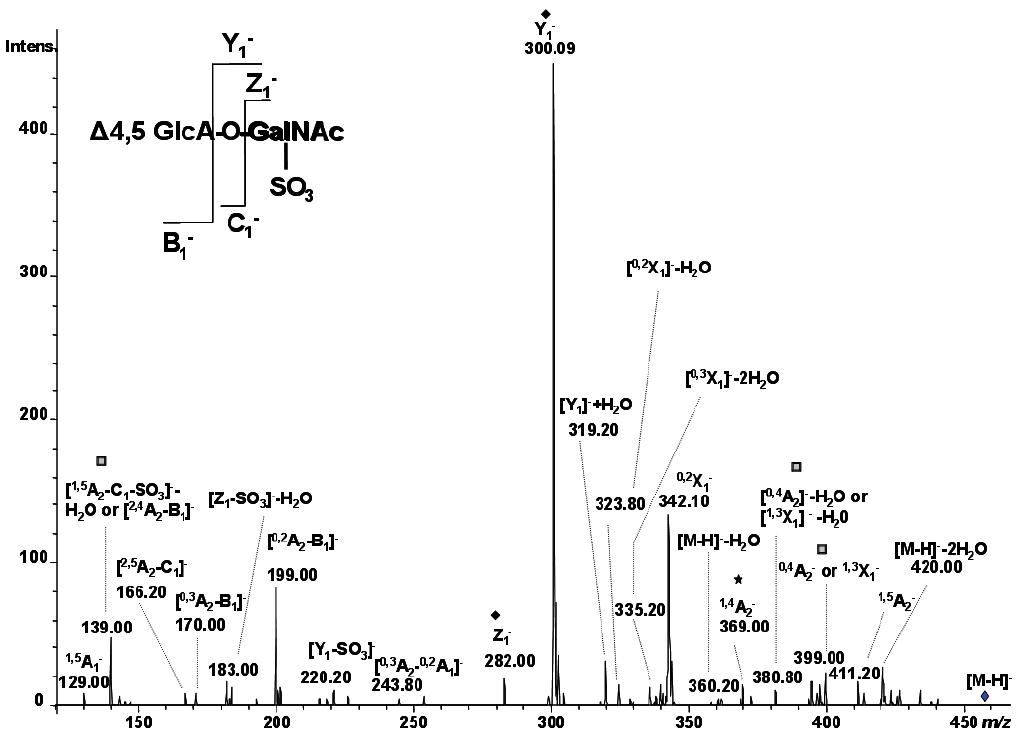
Figure 6. Fully automated chip (-) nanoESI HCT CID MS 2 of the singly deprotonated ion at m/z 458.16 assigned according to mass calculation to monosulfated standard CS disaccharide having the composition [4,5 Δ -GlcA-GalNAc] (4S). Diagnostic ions for GalNAc monosulfation are marked by ( ♦ ); Diagnostic ions for GalNAc (4S) are marked by (*); Ions supporting GalNAc (4S) are marked by ( ■ ). Conditions as for the experiment in Fig.